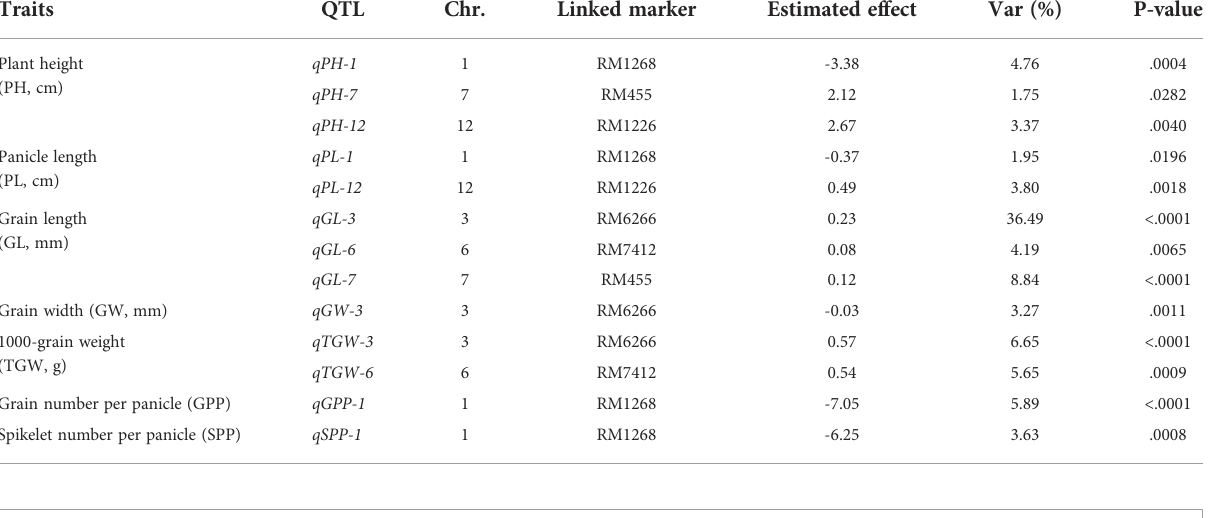
TABLE 1 Summary of 13 QTLs identi fi ed for the six interest traits via the F2 population of